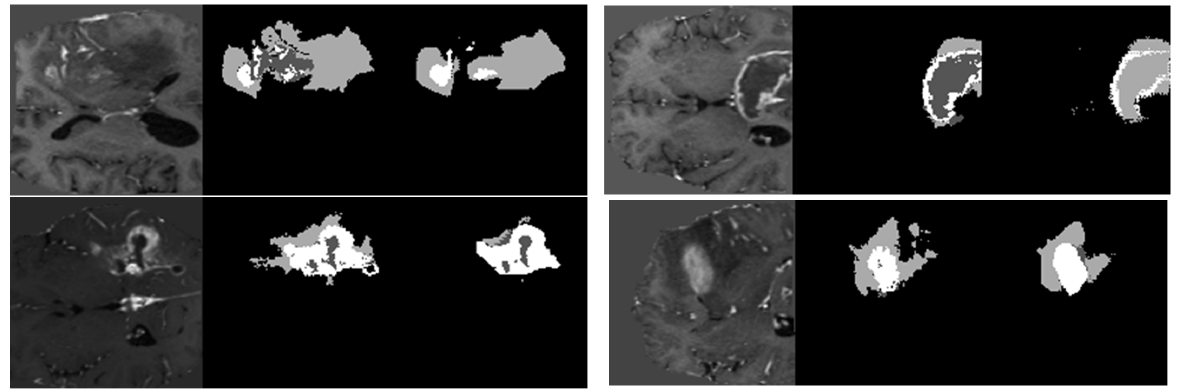
Figure 8. Segmented Output .